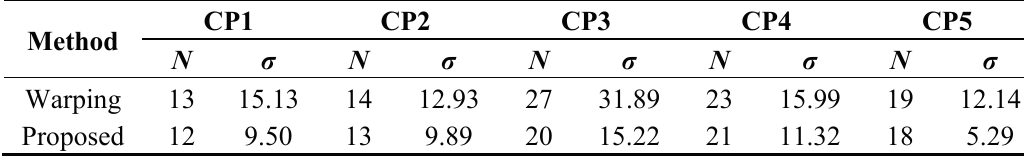
Figure 15. Robot homing Trial